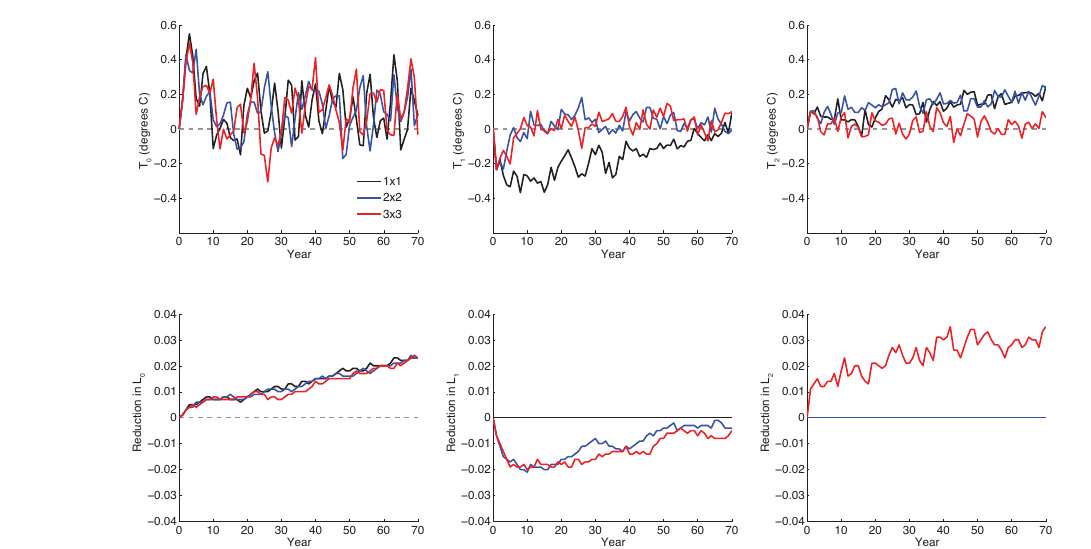
Figure 17. Results for the 3 × 3 case in the design model. Black lines indicate the 1 × 1 sub-case, where L 0 is adjusted to offset changes in T 0 due to 1pctCO2. Blue lines indicate the 2 × 2 sub-case, where L 0 and L 1 are adjusted to offset changes in T 0 and T 1 . Red lines indicate the full 3 × 3 case.